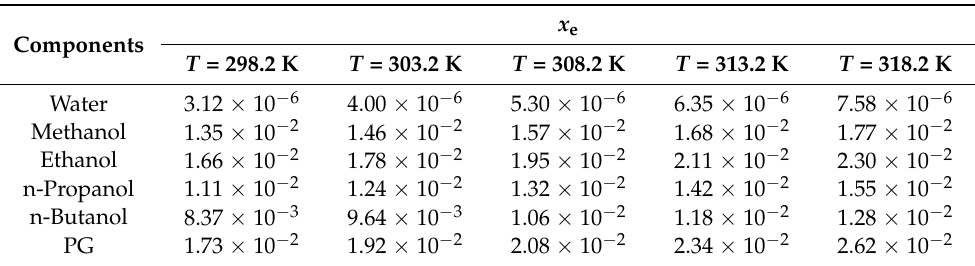
Table 1. Experimental solubilities ( x e ) of trans -resveratrol (TRV) in the mole fraction in six different mono-solvents at 298.2–318.2 K and 0.1 MPa a . Components